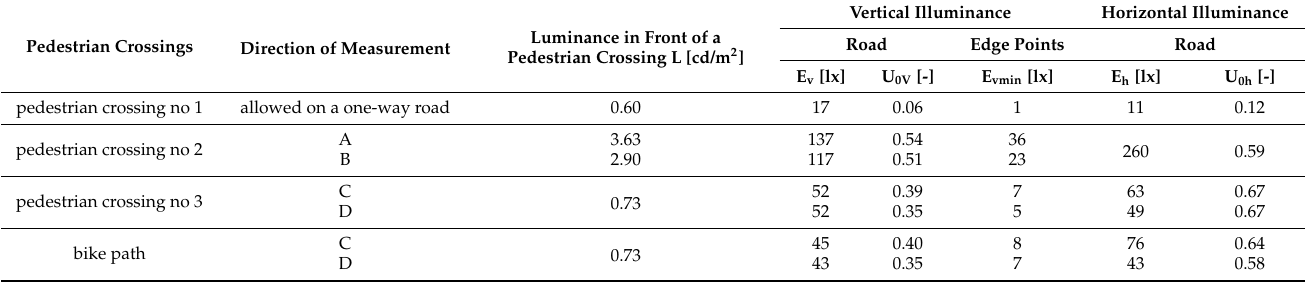
Table 3. Summary of calculation results for the tested pedestrian in line with the Polish method.